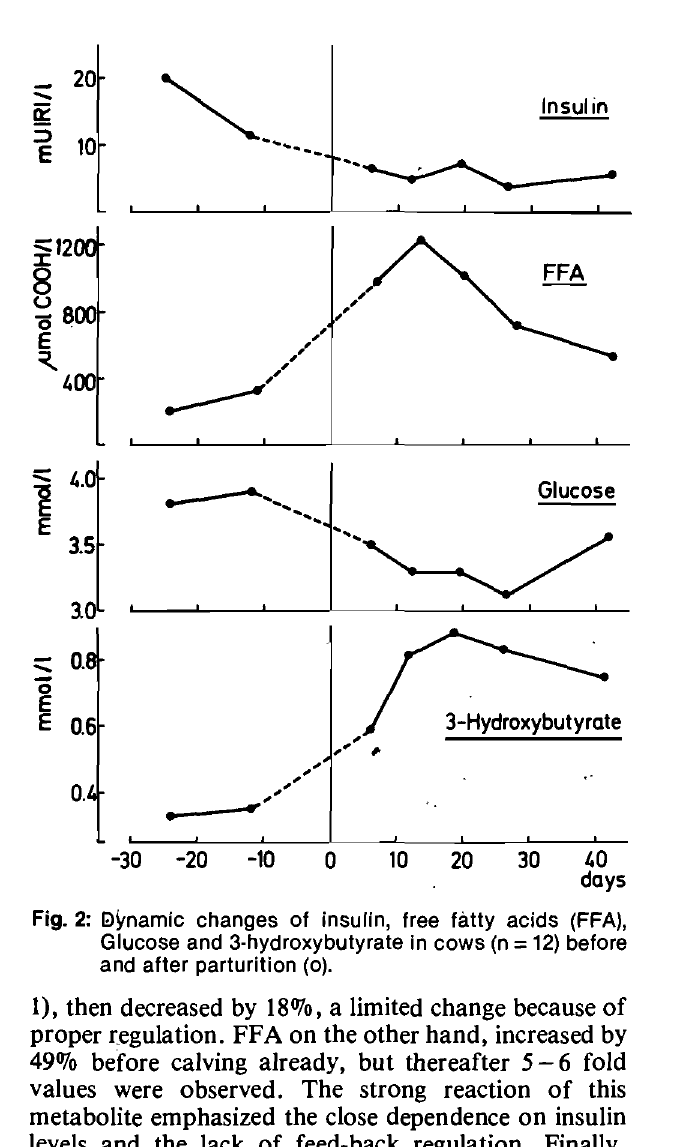
Fig. 2: I:>ynamic changes of insulin, free fatty acids (FFA), Glucose and 3-hydroxybutyrate in cows (n and after parturition (0).